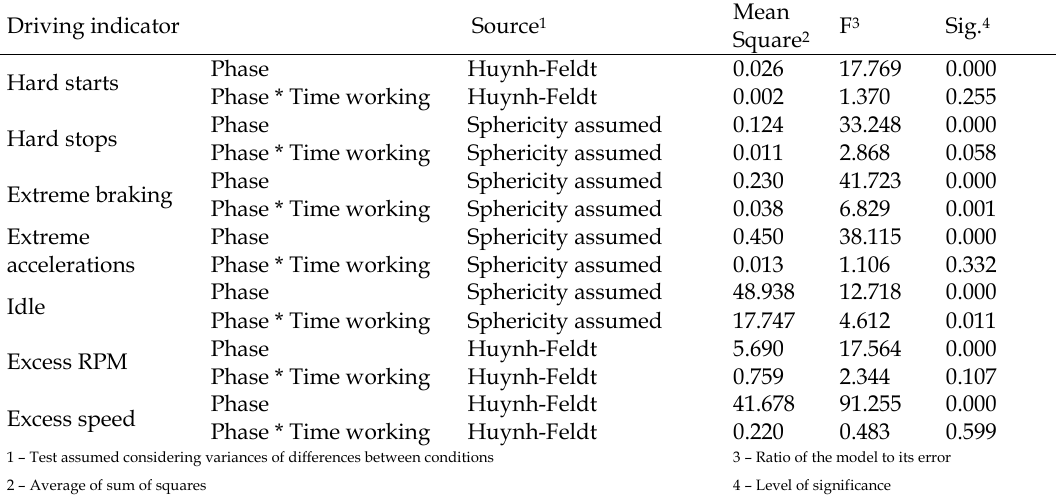
Table 4. Tests of Within-subject effects for the driving indicators analysed with Sidak’s method